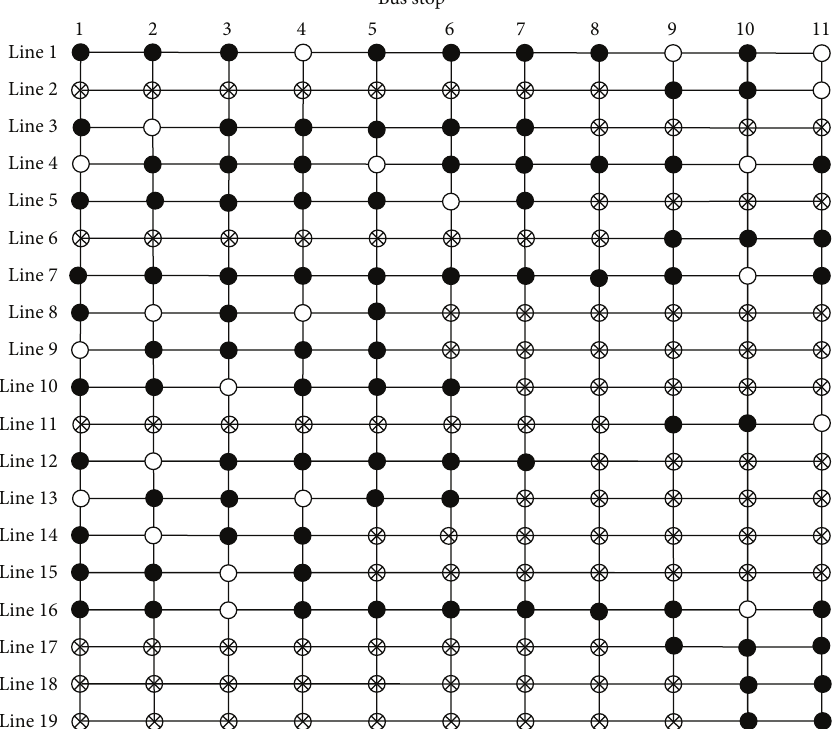
Figure 4: The diagram of skip-stop operation scenario. Note that “ ∙ ” represents stopping, “ ∘ ” represents skipping, and “ ⊗ ” represents not passing by.